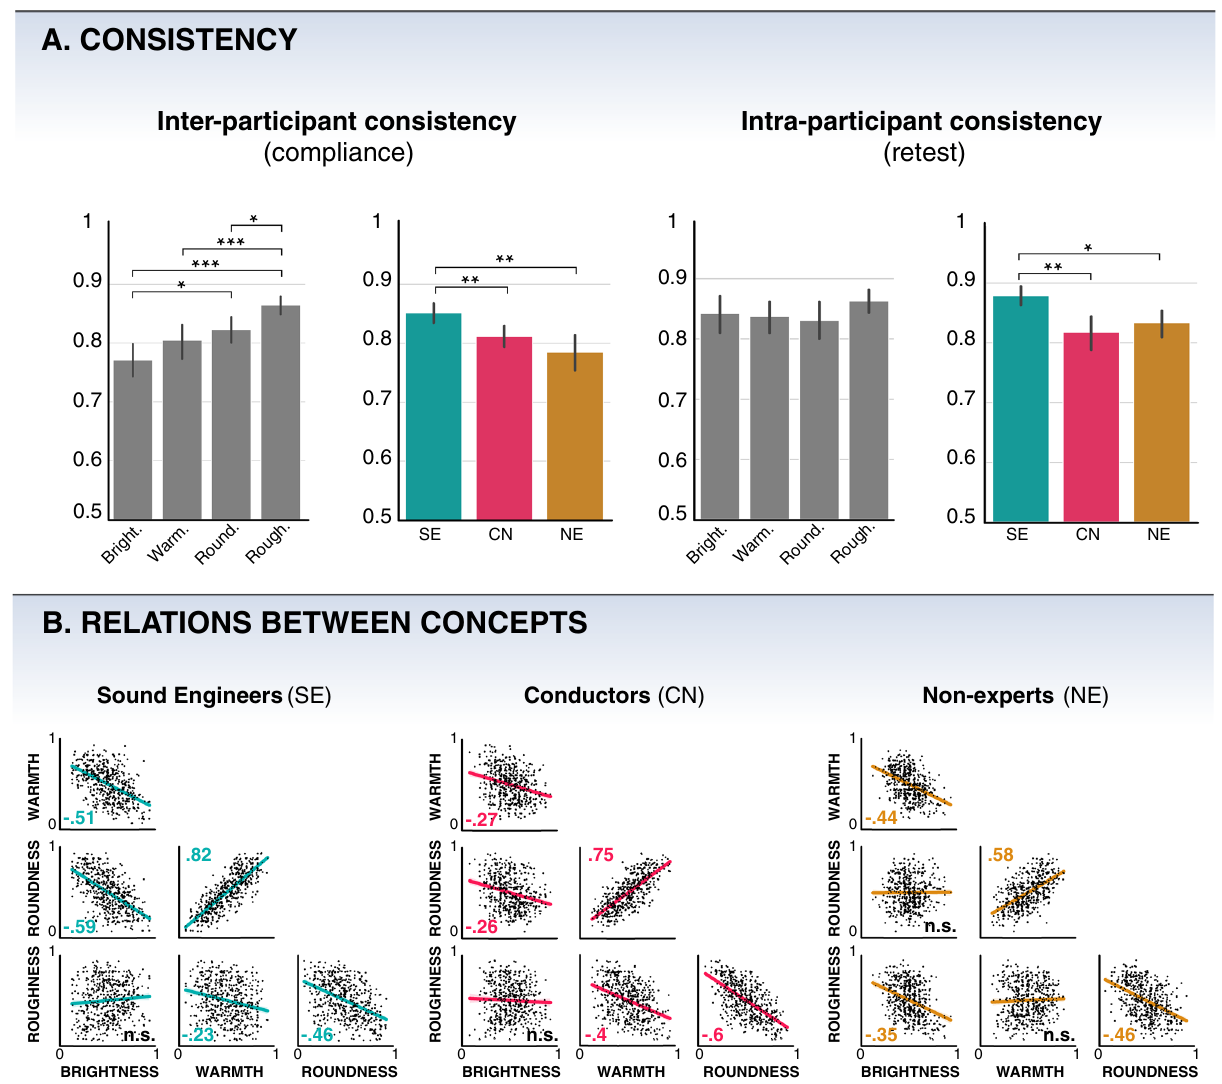
Figure 2. Behavioral results of the BWS experiment. ( A ) inter-participant (left) and intra-participant (right) consistency across concepts and populations (* p < .05; ** p < .01; *** p < .001). ( B ) Correlations between BWS scores of each concept for each group of participants. SE: Sound Engineers (teal), CN: Conductors (red), NE: Non-Experts